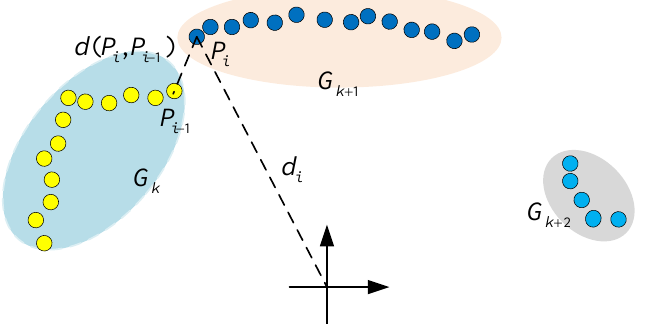
Figure 4. Illustration of laser-based grouping.